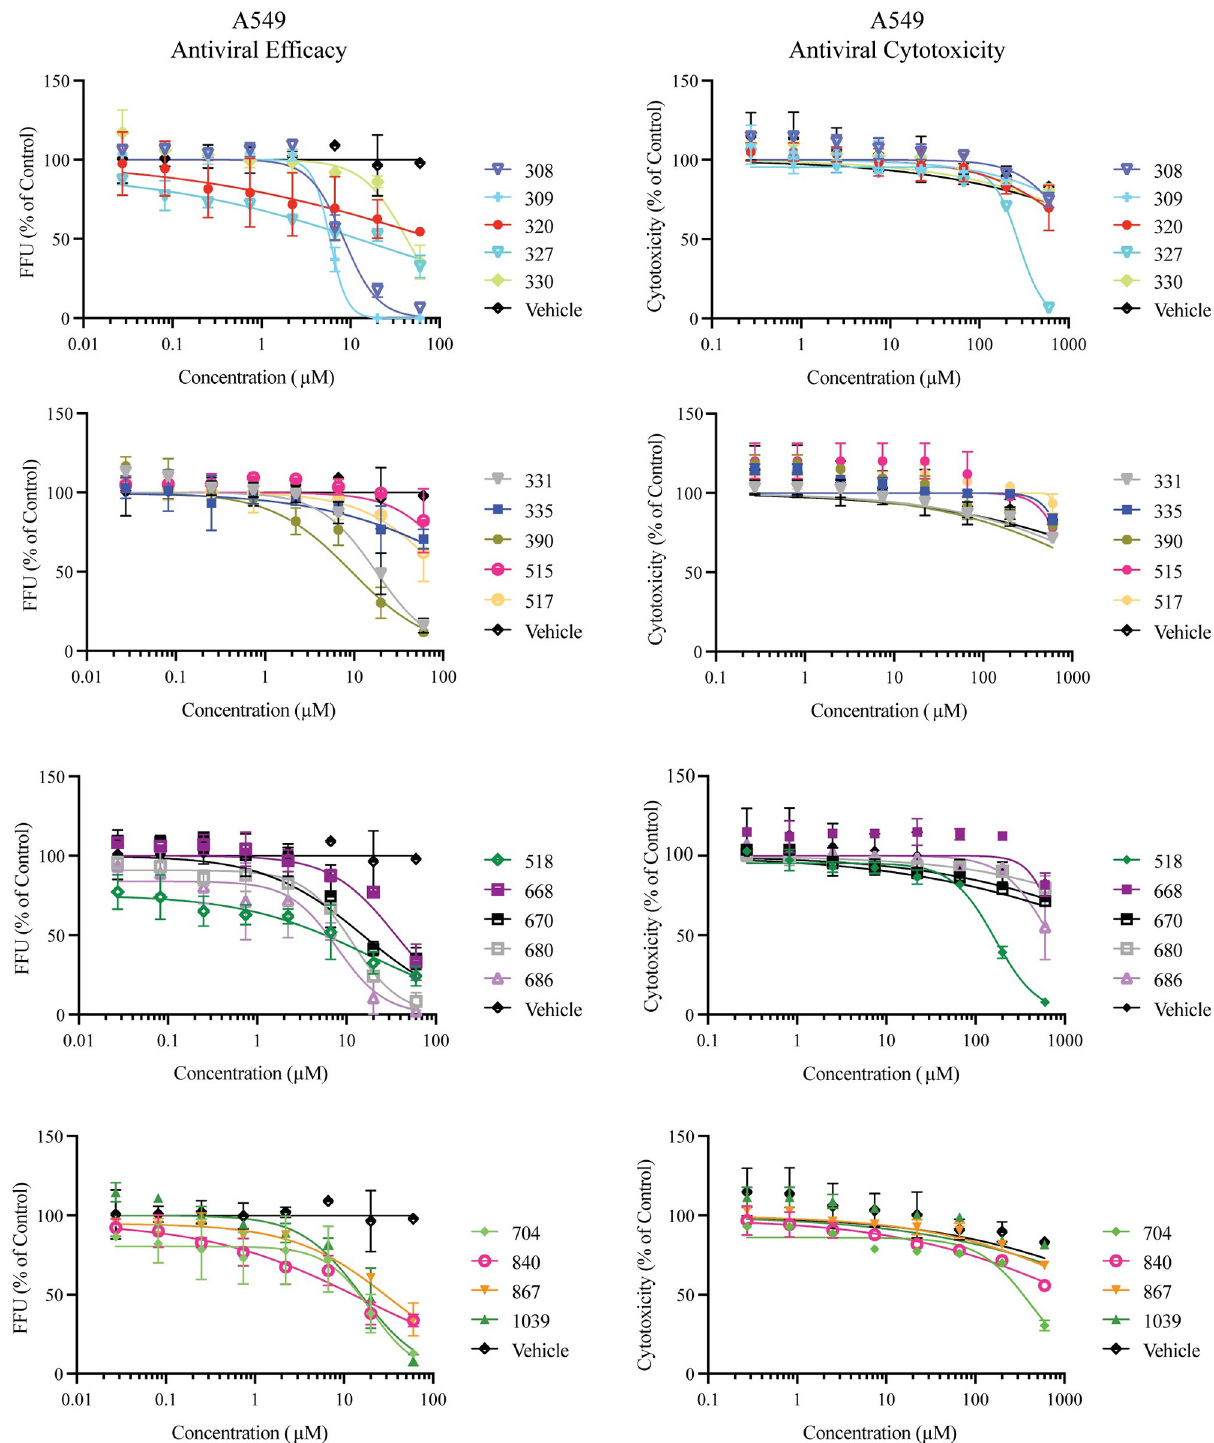
Fig 2. In vitro dose-response and cytotoxicity of compounds against RVFV (MP12). A549 cells were infected with RVFV MP12 then treated with decreasing concentrations of compound. The reduction in virus concentration was measured by FFA at twenty-four hours post infection. Data is representative of three individual experiments with two biological replicates. Error bars represent standard deviation.